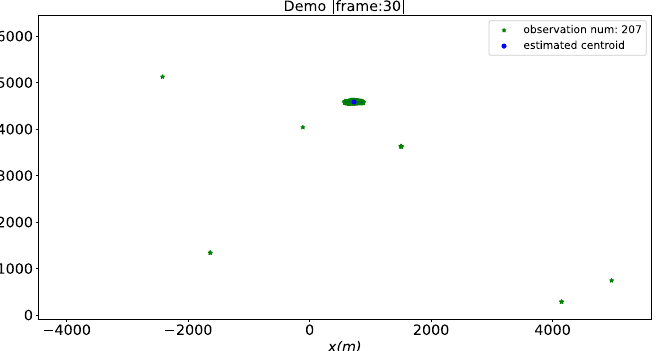
Figure 9. Single target in the Cartesian coordinate system tracking in the 30th frame.